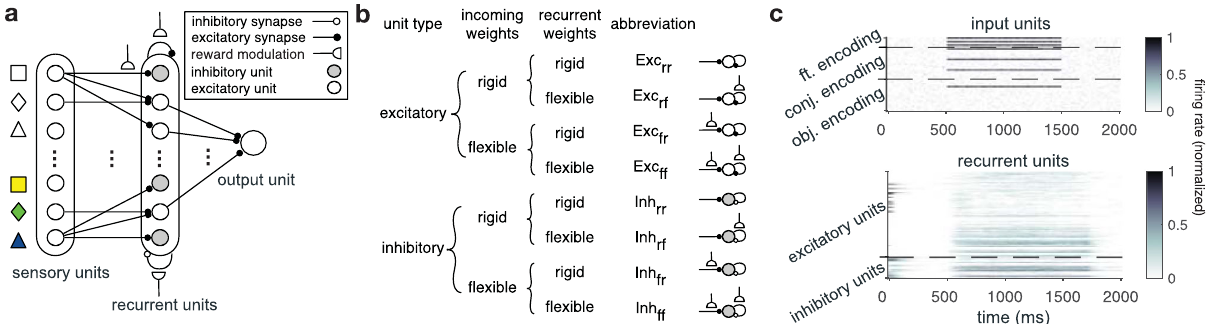
Fig. 4 Architecture of the RNN models. a The models consist of three layers with different types of units mimicking different populations of neurons: sensory units, recurrent units, and an output unit. The recurrent units ( N = 120) included both excitatory and inhibitory populations that receive input from 63 sensory populations encoding individual features ( N = 9), conjunctions of features ( N = 27), and object-identity of each stimulus ( N = 27). Among the recurrent populations only the excitatory recurrent populations project to the output population. Half of the connections from sensory populations and the connections between recurrent populations were endowed with reward-dependent plasticity. b Based on the type of populations and uniform presence/ absence of reward-dependent plasticity in the connections to and between recurrent populations, these populations could be grouped into eight disjoint populations: Exc rr and Inh rr corresponding to populations with no plastic sensory or recurrent connections (rigid weights indicated by subscript r); Exc fr and Inh fr corresponding to populations with plastic sensory input only ( fl exible weights indicated by subscript f); Exc rf and Inh rf corresponding to